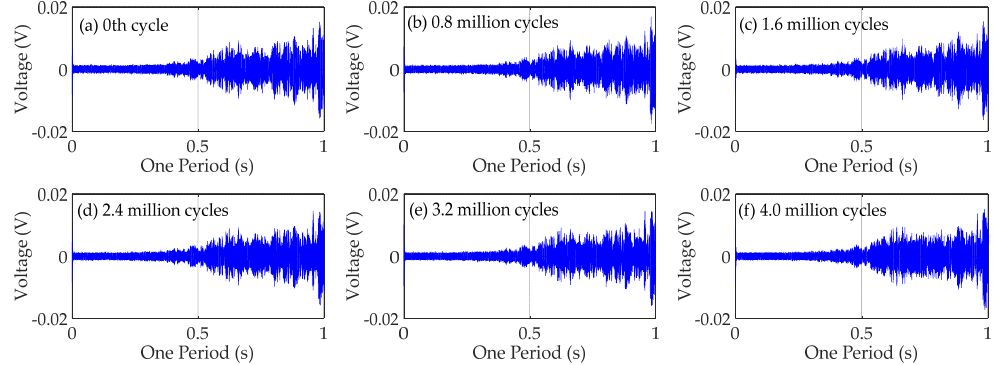
Figure 11. Time domain signals of PZT8 sensor for monitoring north side weld of CB/SB2 joint.